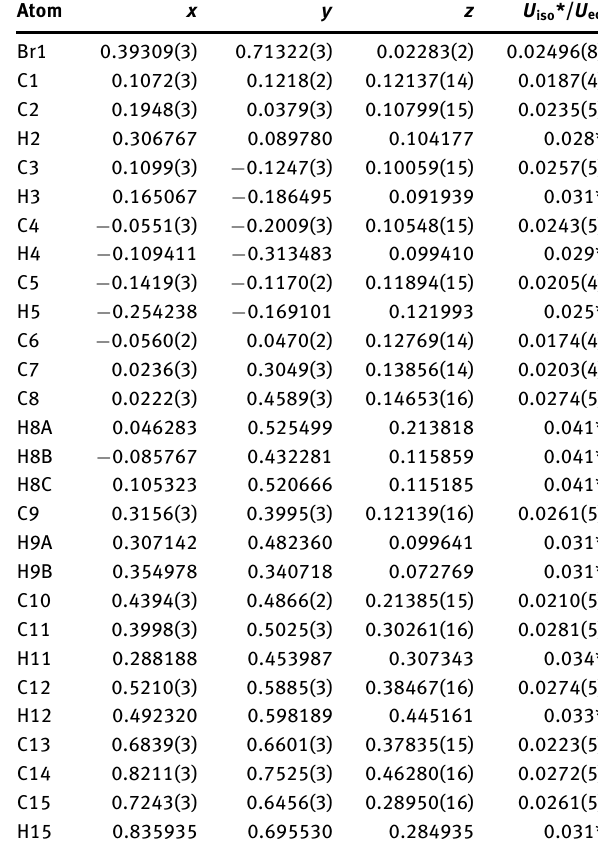
Table 2: Fractional atomic coordinates and isotropic or equivalent isotropic displacement parameters (Å 2